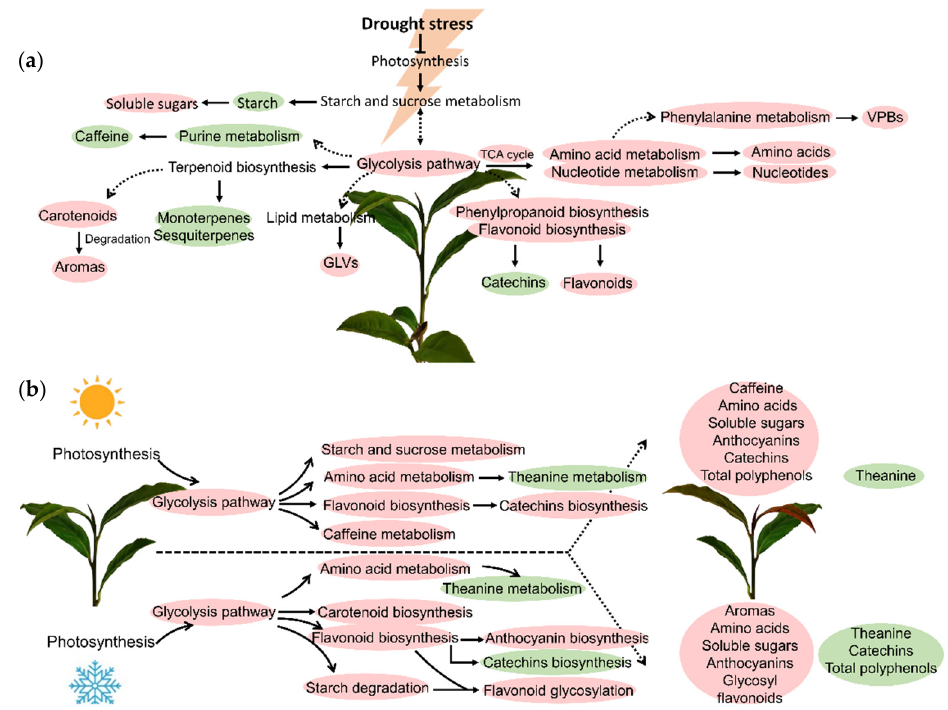
Figure 3. Carbon allocation of tea shoots under drought stress ( a ) and temperature stress ( b ). Green indicates down-regulated metabolism and decreased metabolites, while pink indicates up-regulated metabolism and increased metabolites.